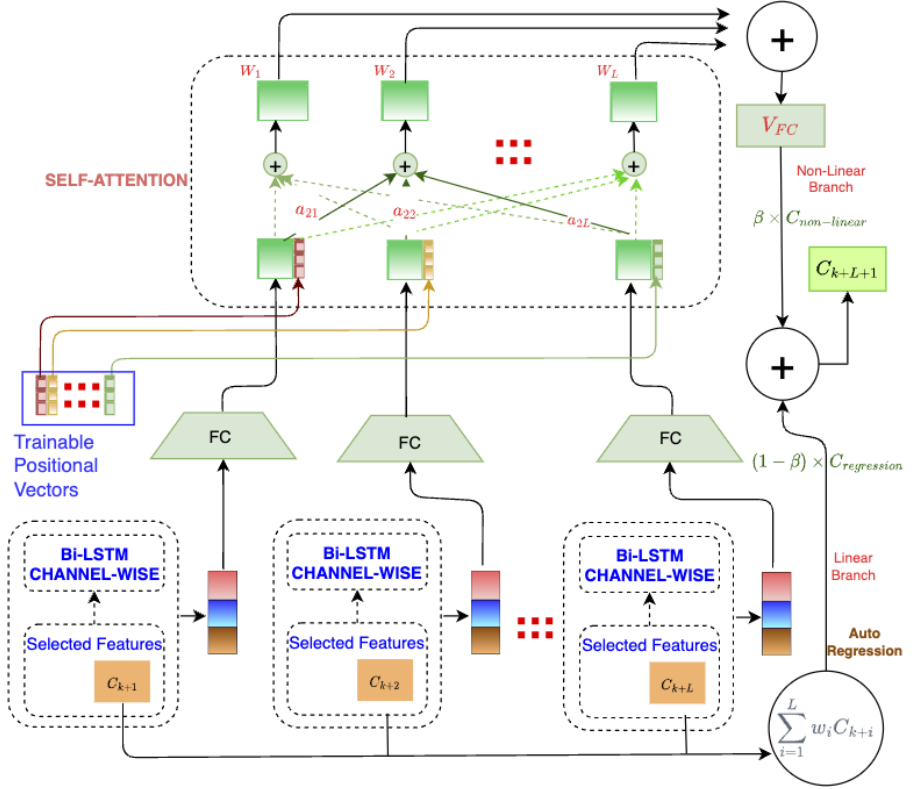
Figure 11. The ultimate model SelfAttention-BFPE-AR for SoH